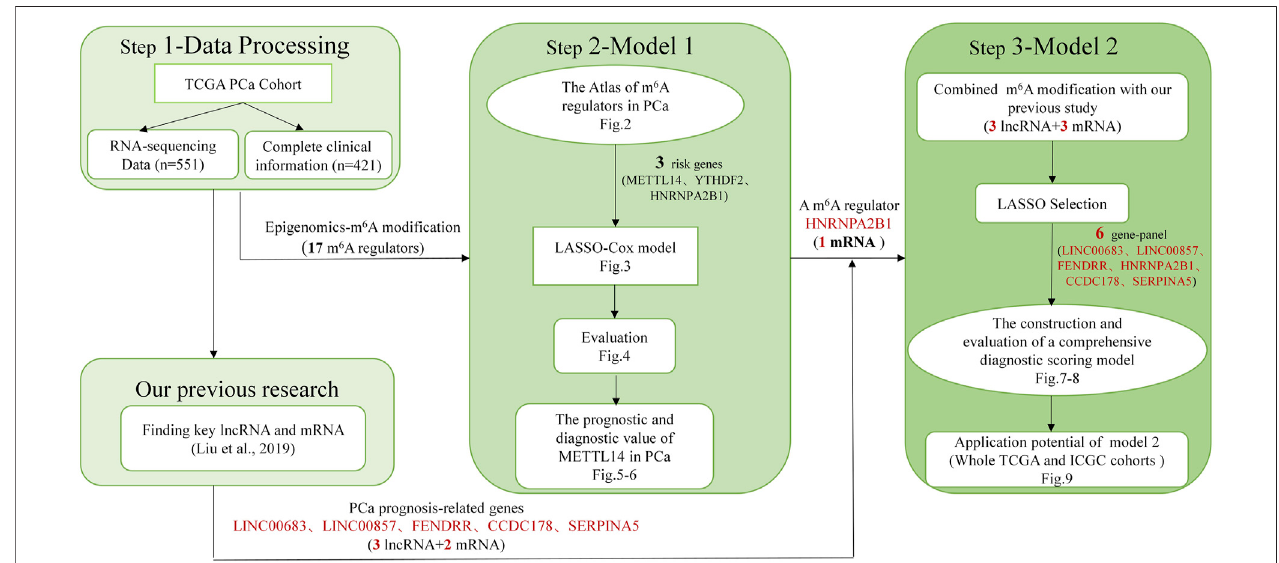
FIGURE 1 | Overall study